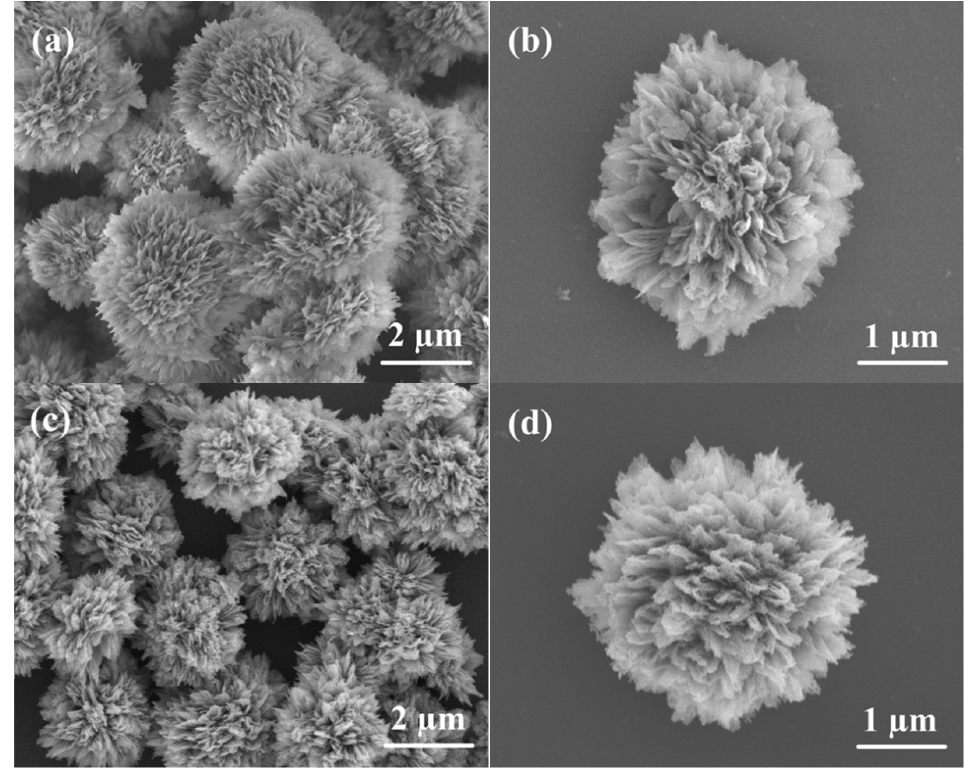
Figure 2. Representative SEM images of ( a , b ) the sea urchin-like 10% Ni-doped Zn 5 (CO 3 ) 2 (OH) 6 precursor and ( c , d ) the corresponding porous sea urchin-like Ni-doped ZnO.